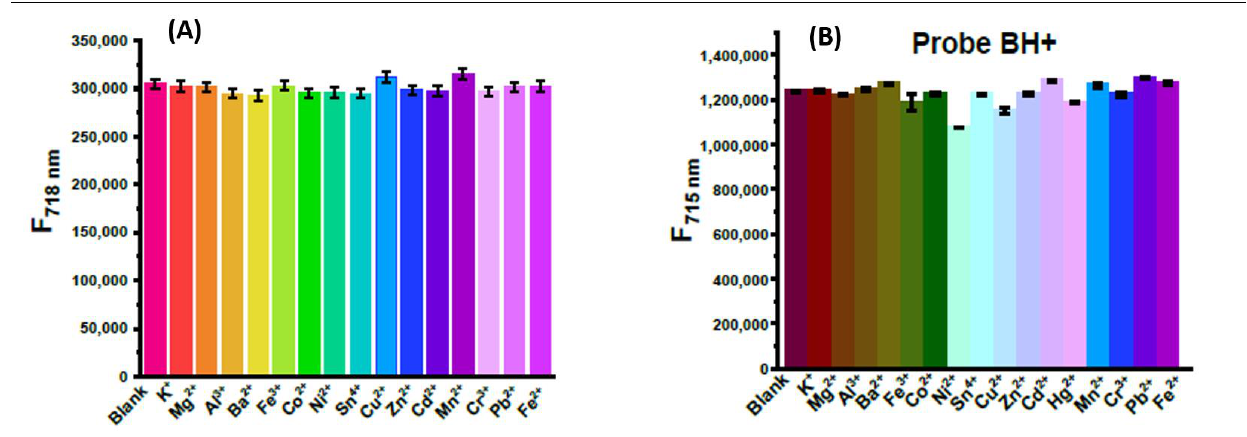
Figure 8. Fluorescence intensities of 10 µ M probes AH + ( A ) and probe BH + ( B ) in the absence and presence of different cations (200 µ M) in pH 7.4 buffers under excitation at 635 nm, respectively.